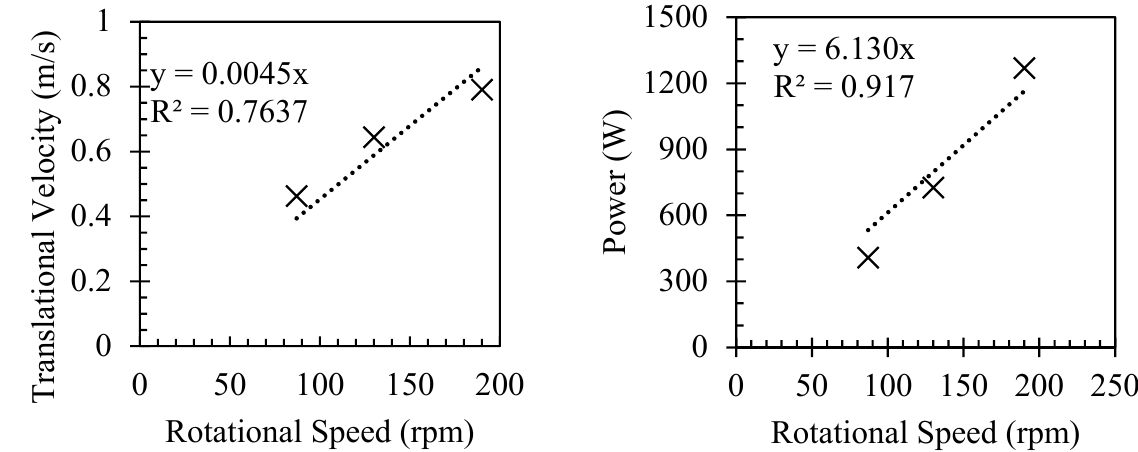
Figure 12. Left: The relationship between agitator speed and particle average translational velocity (m/s). Right: The relationship between agitator speed and simulation power (W).